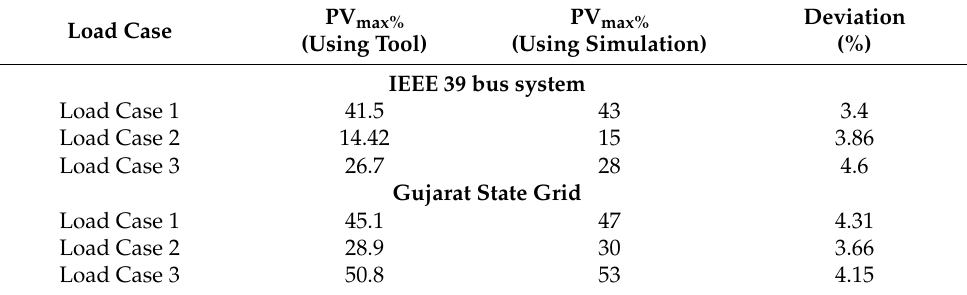
Table 6. Validation results for studied power